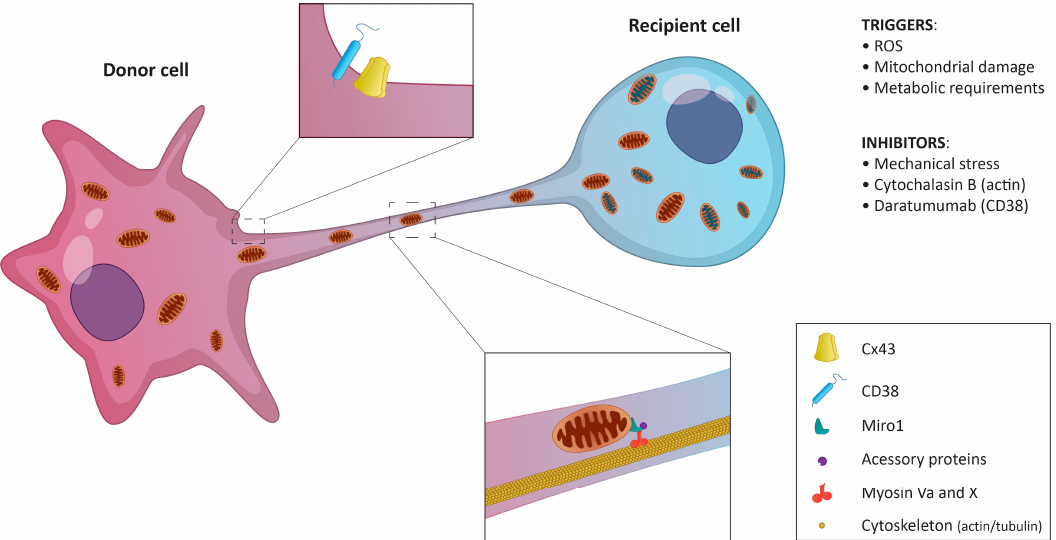
Figure 2. Schematic representation of mitochondrial transfer via tunneling nanotubes. The donor cell, usually a non-cancerous cell, sends mitochondria to the recipient cell. In certain cases, the transfer is possible in both directions. Key regulatory molecules and triggers are listed.